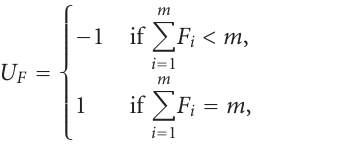
Figure 5: Theoretical correct probability of the overall decision for sensor networks with 9 sensors in Gaussian channels ( A = 0 . 9, β = 3 . 5, d =